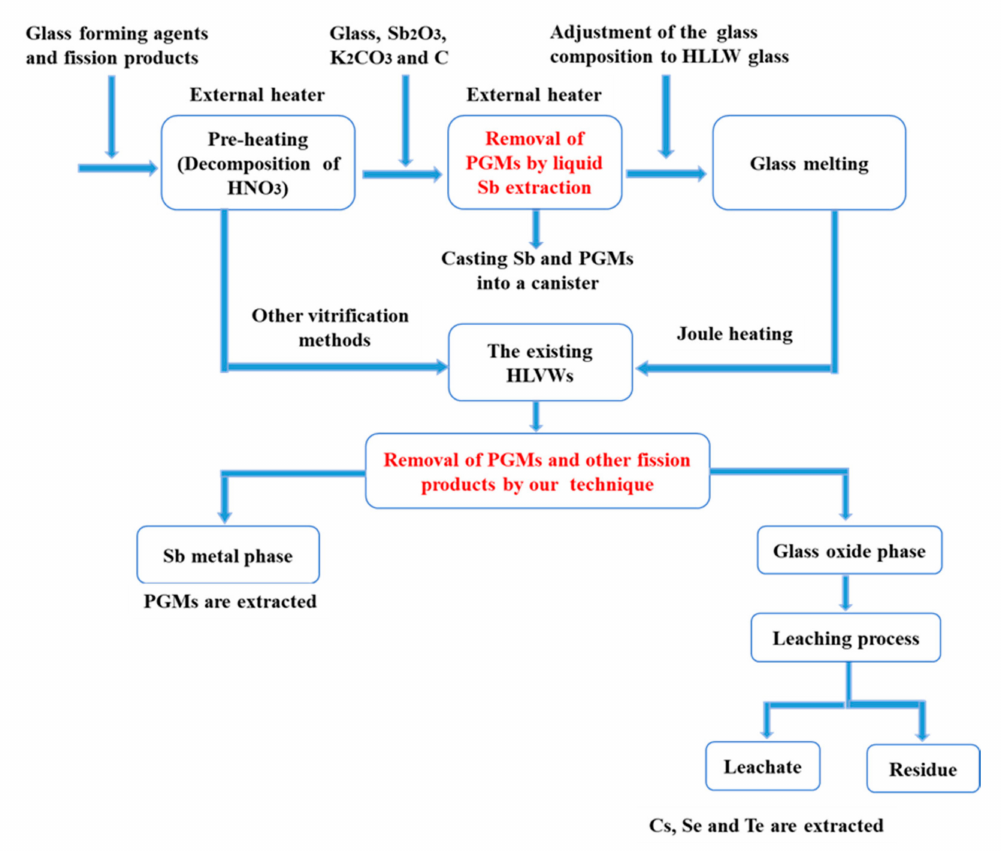
Figure 8. Flow chart of the separation of platinum group metals (PGMs) and other fission products by our proposed